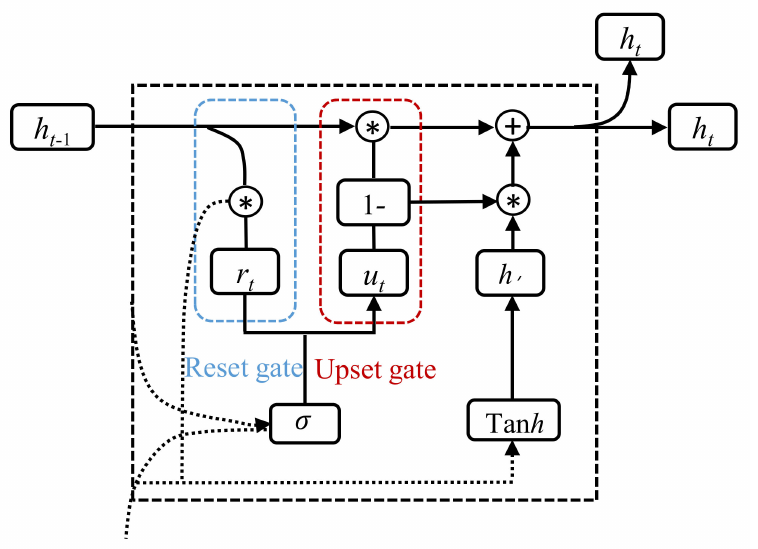
Figure 3. Structure chart of